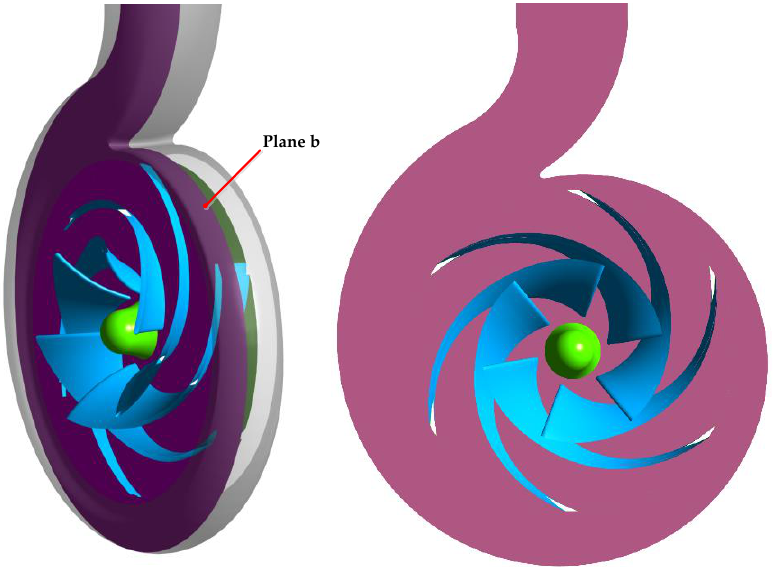
Figure 11. The position of the axial plane b .